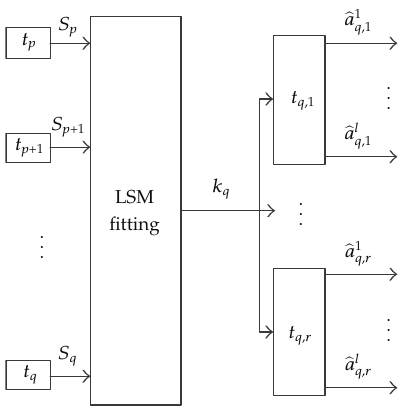
Figure 2: Illustration of predicting track irregularity amplitudes over all sampling points in the unit section Sec after the q th Track Geometry Car